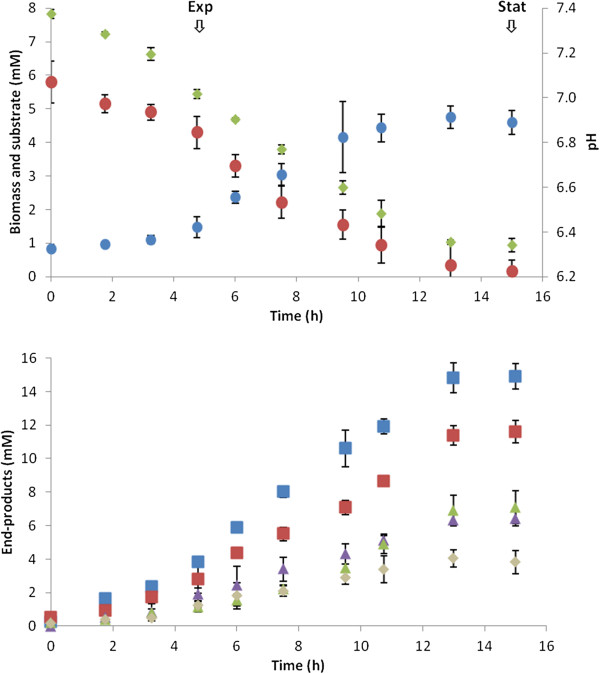
 Fermentation growth and metabolite production. Cellobiose utilization, biomass production, pH change, and metabolite production plots of C. thermocellum grown in 1191 medium batch cultures on 2 g l-1 cellobiose. Arrows indicate sampling points for exponential and stationary phase proteomic analysis. Biomass (blue circle), cellobiose (red circle), pH (olive green diamond), H2 (blue square), CO2 (red square), acetate (purple triangle), ethanol (olive green triangle), formate (tan diamond).